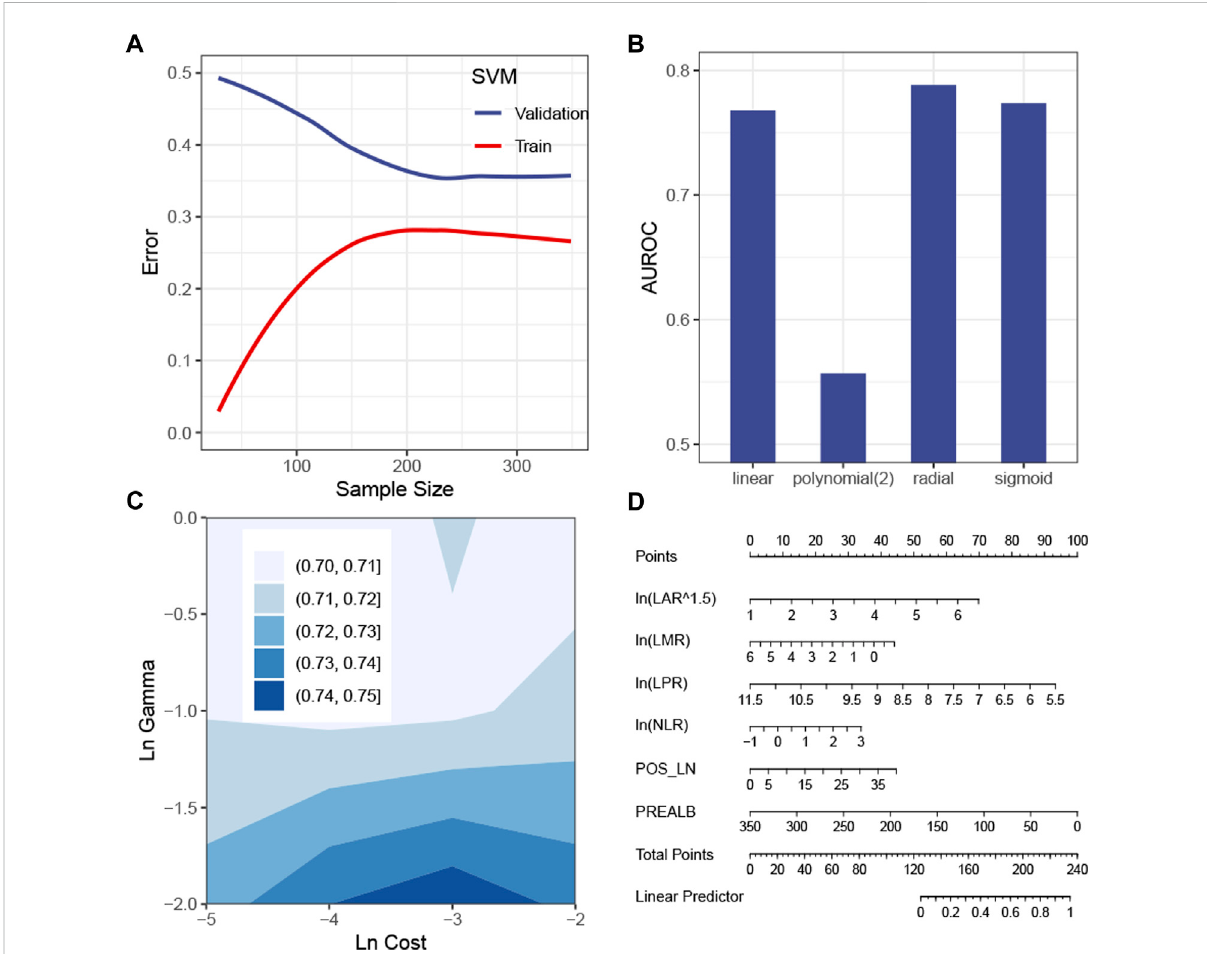
FIGURE 3 ConstructionoftheSVMmodel. (A) LearningcurveoftheSVMmodel. (B) Simulationtestofthetuning kernel functionmeasuredbytheAUROC. (C) Simulation test of tuning cost and gamma measured by the AUROC. (D) Global surrogate model visualized by a nomogram to approximate the predicted probability of being positive by the SVM model. Abbreviations: SVM, support vector machine; AUROC curve, area under the receiver operating characteristic curve; LAR, lymphocyte – albumin ratio; LMR, lymphocyte – monocyte ratio; LPR, lymphocyte – platelet ratio; NLR, neutrophil – lymphocyte ratio; POS_LN, number of positive lymph node; PREALB,